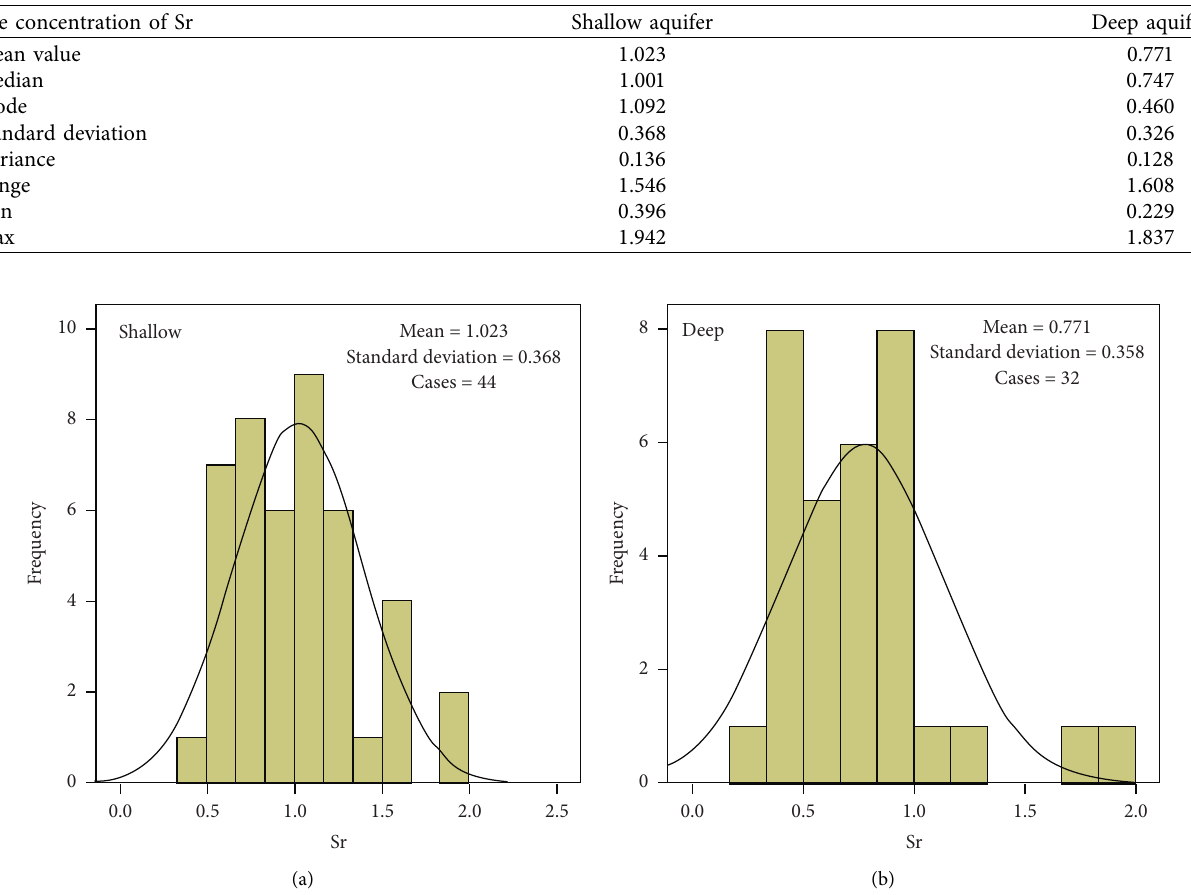
Figure 2: Frequency histogram of strontium concentration in shallow and deep groundwater.